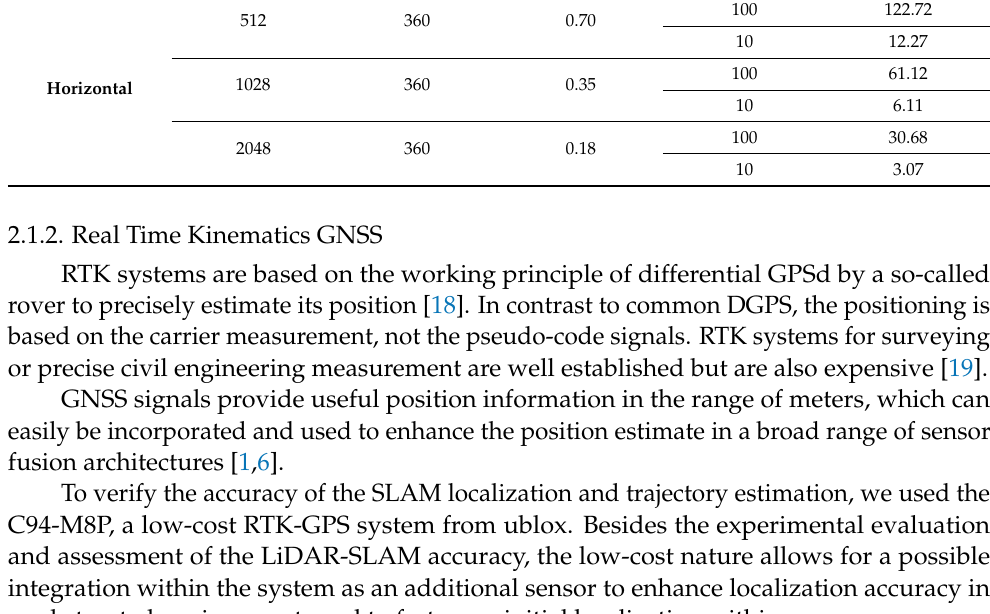
Table 1. The distance of the measuring points depends on the distance [17].